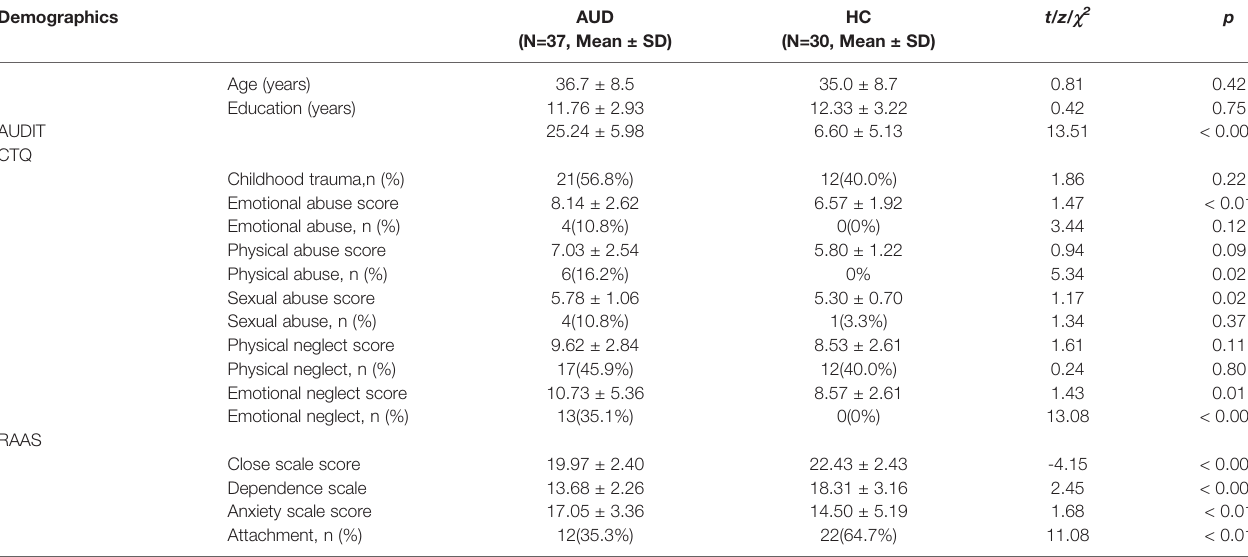
TABLE 1 | Comparison between patients with alcohol use disorders and healthy control groups. Demographics